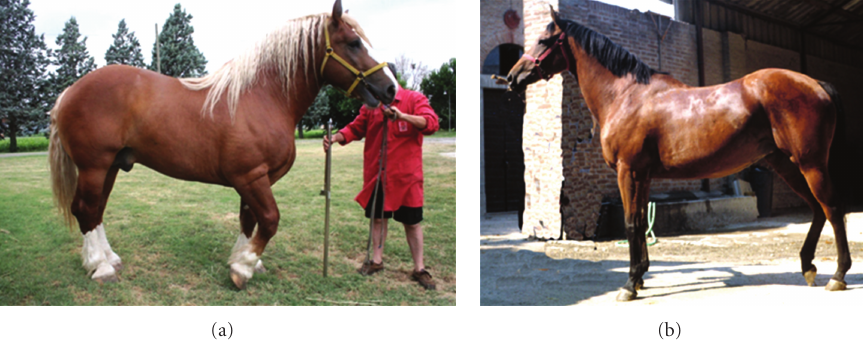
Figure 1: Horses of extreme and opposite morphological types:(a) Rapid Heavy Draft (brachymorphic type or heavy) and (b) Italian Trotter (dolichomorphic type or